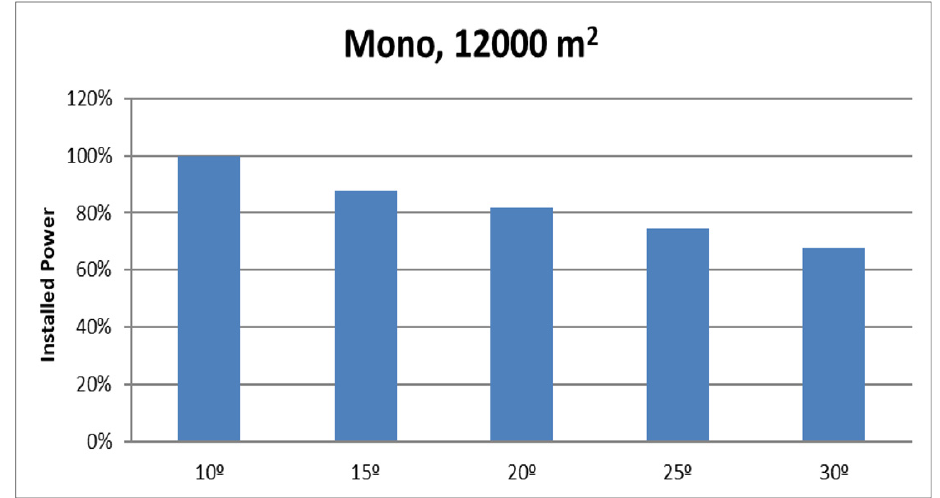
Figure 4. Installed power as a function of module inclination and surface available.